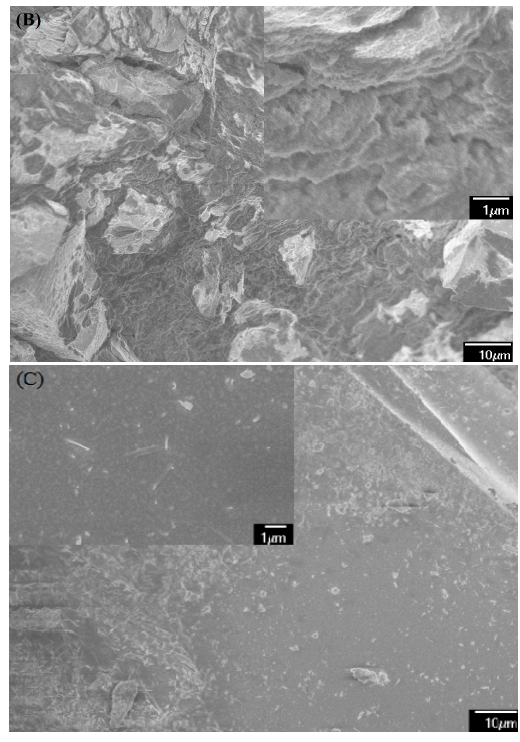
Figure 1. SEM images of humins ( A ), cured ADH ( B ), and cured HPFA ( C ).